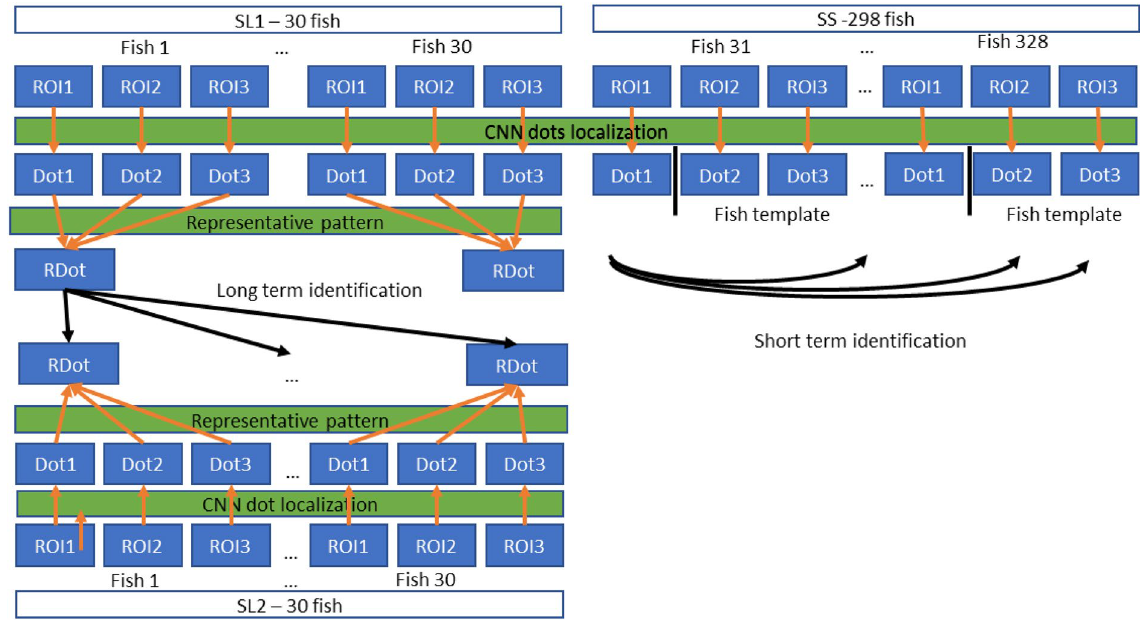
Figure 6. E Scheme of dot localization-based approach to identification. The dots (Dot) for each ROI of each fish are detected using CNN. The dots are used for short-term identification, where two images are used as the pattern and one image as an unknown image. The representative dot pattern (RDot) is calculated for each fish from all fish dot patterns. The representative dot pattern is used for long-term identification for the SL1, SL2, SL3 and SL4 datasets.